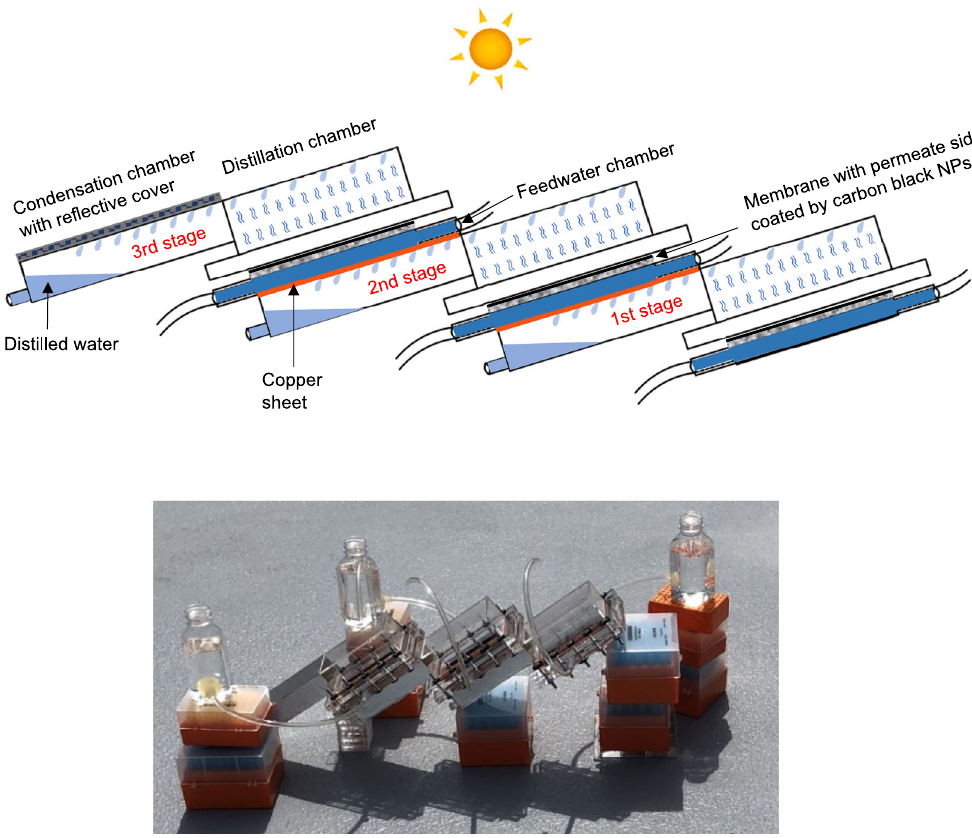
Fig. 5 The schematic and photograph of the three-stage planar passive permeate-side-heated solar membrane distillation system. The inner dimensions of different chambers of this three-stage planar system were as follows: feedwater chamber [120 mm (L) × 50 mm (W) × 14 mm (H)], distillation chamber [the upper distillation chamber above the fl ange: 130 mm (L) × 60 mm (W) × 40 mm (H); the lower distillation chamber within the fl ange: 120 mm (L) × 50 mm (W) × 14 mm (H)], and condensation chamber [150 mm (L) × 60 mm (W) × 30 mm (H)]. The dimensions of membranes were 120 mm (L) × 50 mm (W), and the dimensions of copper sheets were 150 mm (L) × 67 mm (W) × 4 mm (H). The copper sheets served as both the top of the condensation chamber of the preceding stage and the bottom of